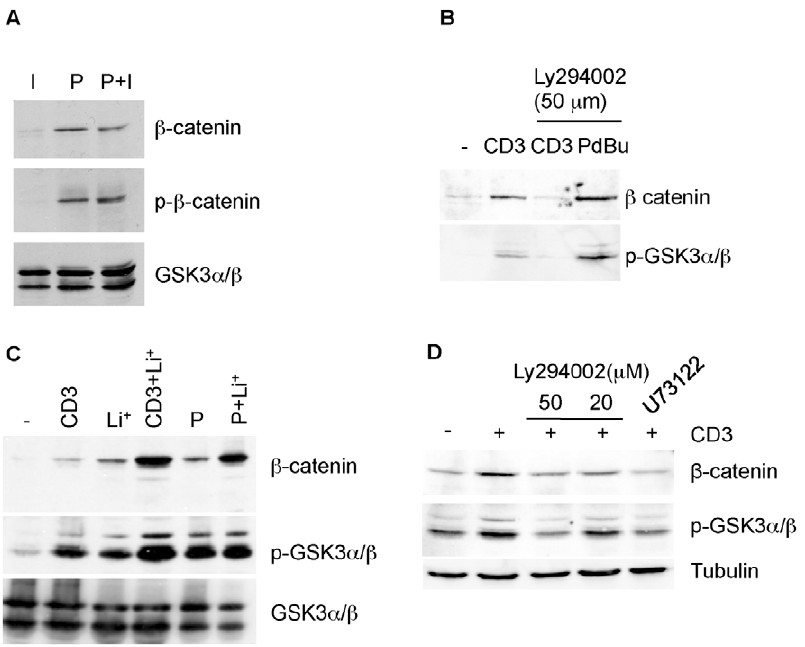
Figure 6. PKC can also regulate the expression of b -catenin. (A) T cells were incubated for 18 hours with either Ionomycin (I, 100 nM), PDBu (P, 10 ng/ml), or a combination of PDBu and Ionomycin (P + I). Total cell lysates were used for Western blotting with anti- b -catenin, anti-phospho- b - catenin and anti-GSK3. (B) T cells were stimulated for 18 hours with either anti-CD3 or PDBu in the absence or presence of the PI3K inhibitor Ly294002. Total cell lysates were analysed by Western blot with anti- b -catenin and anti-phospho-GSK3. (C) T cells were stimulated for 18 hours with either plate-bound CD3 (CD3), lithium (Li + ) or PDBu (P), as shown, and analysed by Western blot with the antibodies indicated. (D) T cells were stimulated with anti-CD3 for 18 hours either in the absence or presence of the PI3K inhibitor Ly294002 (20 and 50 m M) or the PLC inhibitor U73122 (10 m M). Total cell lysates were analysed by Western blot with anti- b -catenin, anti-p-GSK3 a / b and anti-tubulin. A representative figure of two experiments is shown. (PLC) on phosphatidylinositol 4,5-bisphosphate (PIP2), in the